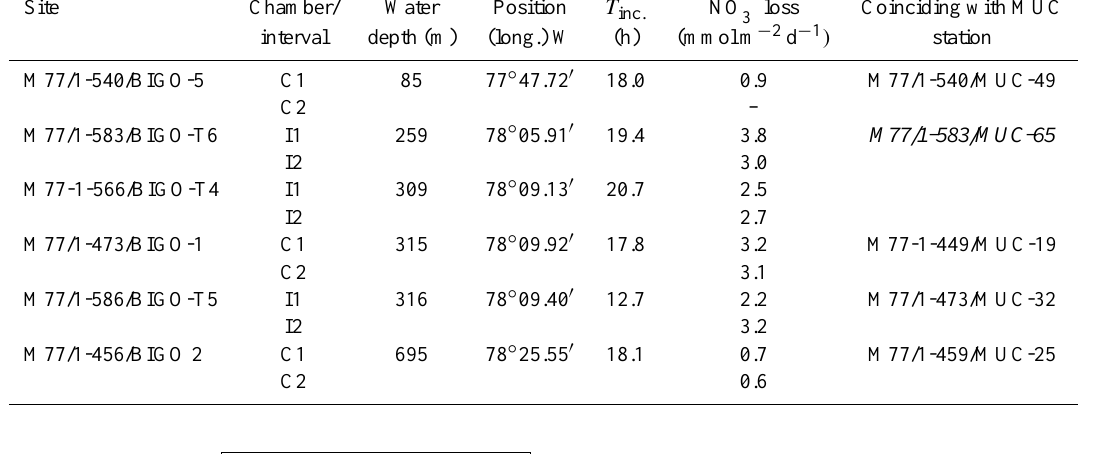
Table 5. Benthic stations where in situ fluxes of nitrate loss (negative nitrate fluxes) were determined. The notations C1 and C2 refer to chambers 1 and 2, respectively. All stations lie on the latitudinal transect at 11 ◦ S. T inc. denotes the duration of the chamber flux measure- ments. Negative and positive fluxes indicate uptake and release from the seabed, respectively. During the flux measurements of BIGO-T, the chamber water was replaced once with ambient seawater halfway through the incubation period. For these deployments, I1 refers to the time interval after driving the chamber into the sediment, I2 refers to the time interval after the chamber water was replaced. Also listed are the coinciding MUC stations for the foraminiferal studies. Italics indicate that the multicorer sample for the foraminiferal studies has been taken at a close by site at the same water depth, which is ∼ 0 ◦ 07 0 south of the lander station.